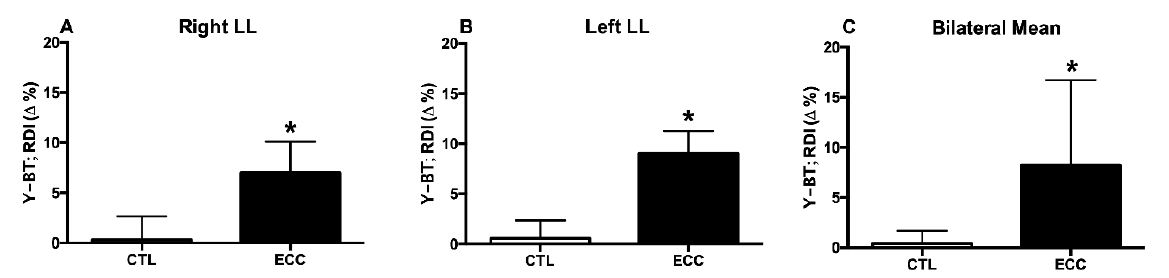
Figure 3 . Comparison of the changes (Post-Pre) in Balance (Y-BT), expressed as range distance index (Δ RDI%) after training between CTL and ECC group. (A). Δ%RDI right LL, (B). Δ%RDI left LL and (C). Δ% RDI bilateral average. * p <0.05. Results are shown as mean (SD)